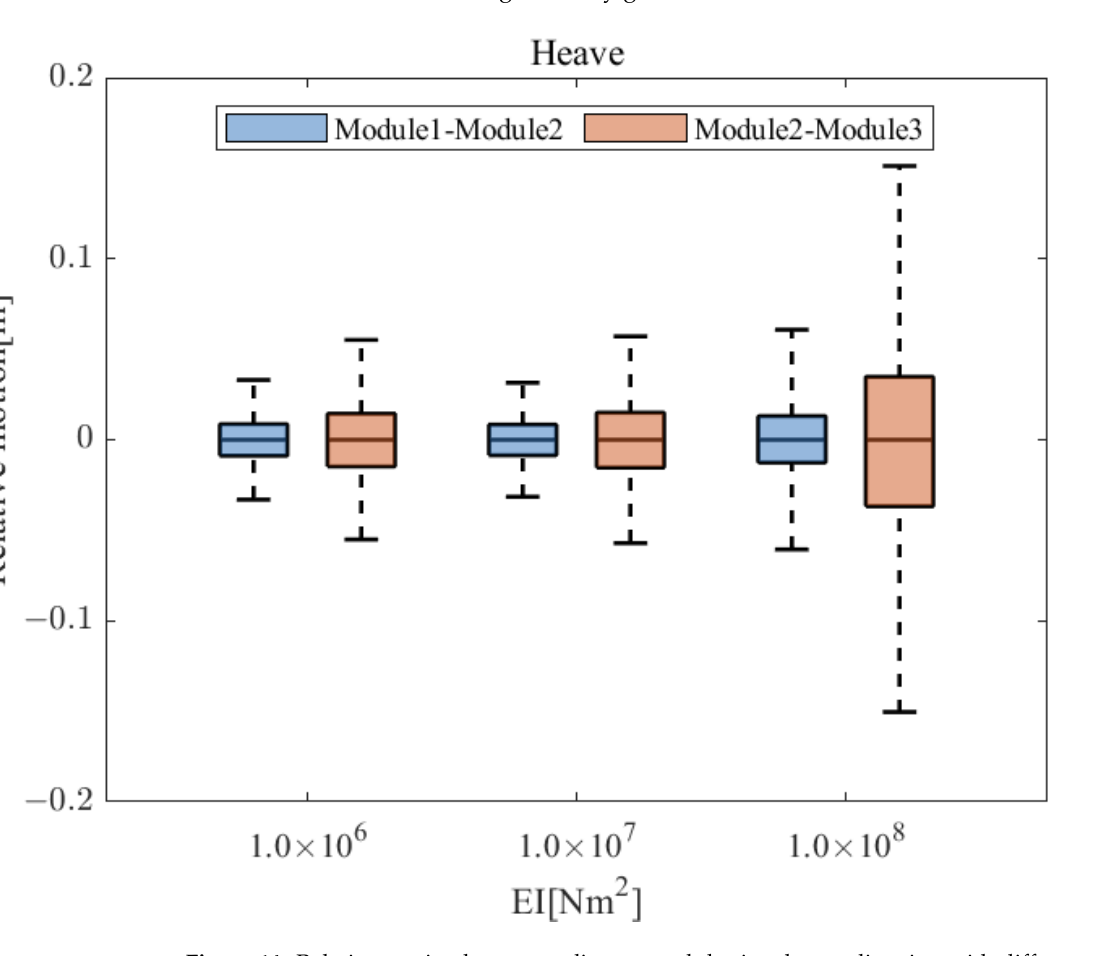
Figure 14. Relative motion between adjacent modules in a heave direction with different connector stiffness.